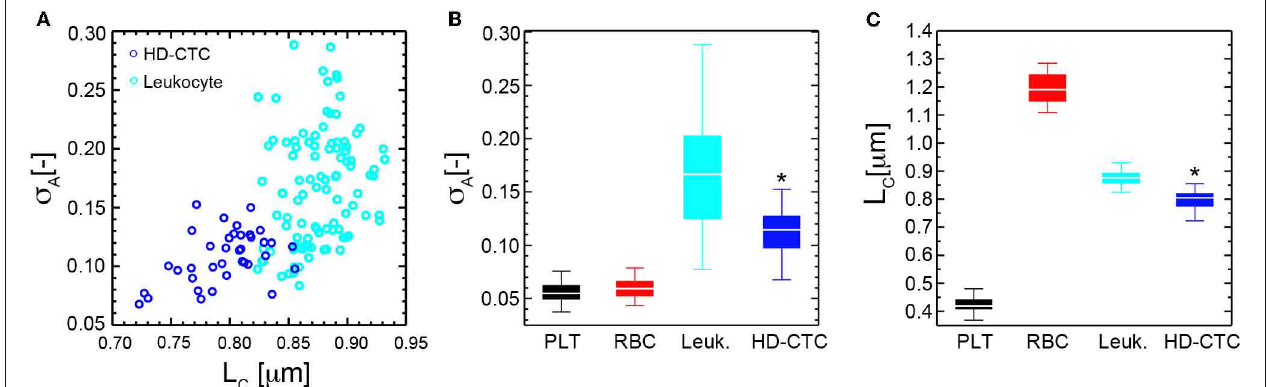
FIGURE 5 | Mass density fluctuation and spatial correlation metrics for normal blood cell subpopulations and HD-CTCs. (A) Scatter plot of spatial correlation length vs. amplitude fluctuations for HD-CTCs and leukocytes from breast cancer patient. (B) Box plot comparing population averages of the axial resolved DIC amplitude fluctuations averages of the